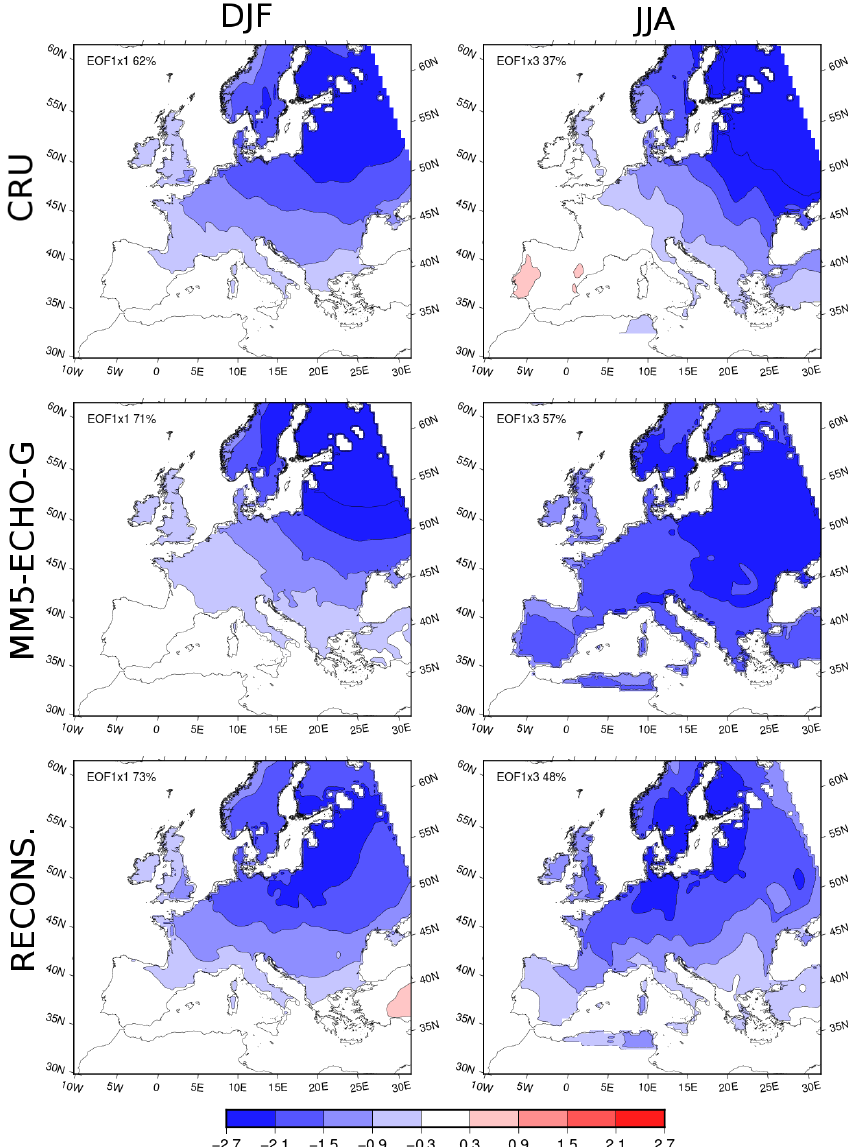
Figure 8. First EOF of winter (left) and summer (right) SAT. Rows depict the results for the CRU data set (top), the MM5-ECHO-G simulation (middle) and the reconstructions (bottom). For the first case, the 1901–1990 period is employed, whereas for the other the period 1500–1990 is considered. Note that the patterns carry the units of the variable, and thus they are proportional to the square root of the variance that each pattern represents. Hence, and to facilitate the comparison, each pattern has been multiplied by a scaling factor, indicated in the top right corner of the figure. The percentage of total variance represented by each pattern is also indicated. The units are ◦